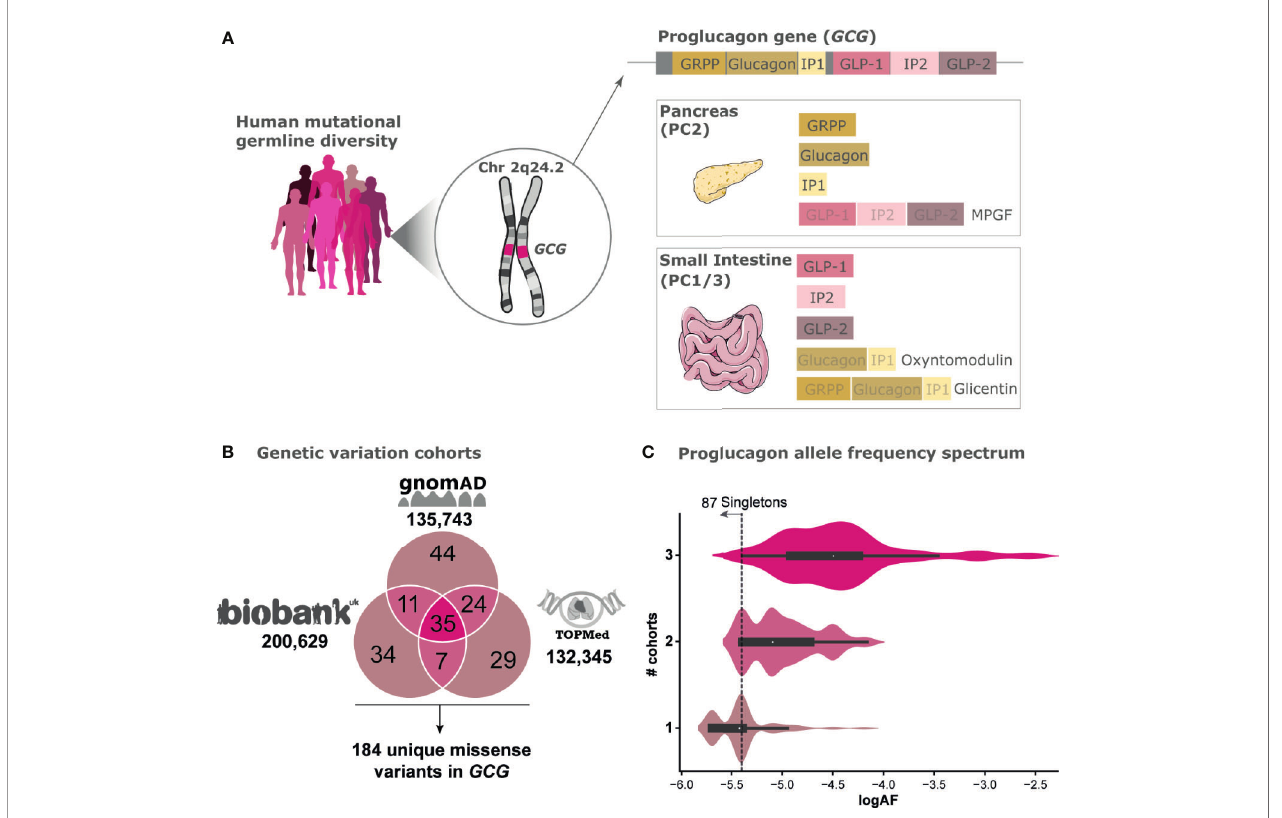
FIGURE 1 | Genetic variation of the Proglucagon peptide hormone gene. (A) Human germline genetic variation diversity of the proglucagon gene GCG located on chromosome (2q24.2) with expression mainly in the pancreas and the small intestine (see gtexportal.org for expression data). Cleavage enzymes differently cleave the proglucagon precursor into distinct peptides. (B) Cross-sectional mutational landscape aggregated from three independent genomic sequencing efforts including gnomAD [122,439 exomes/13,304 genomes, excluding individuals also found in TOPMed (12)], UK Biobank [200,629 exomes (13)], and TOPMed [132,345 genomes (14)] leading to a total set of 184 unique missense variants spanning 117 positions found in a total set of 468,717 unique individuals ( SI2 ). (C) Allele frequency (AF) spectrum of variants found in one, two, or all three cohorts respectively. The threshold for singletons, i.e., variants only carried by a single individual within a given cohort, are